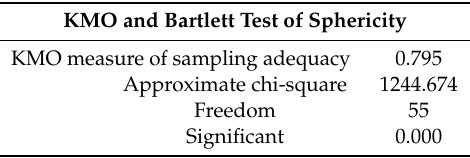
Table 3. KMO (Kaiser-Meyer-Oklin) and Bartlett Test of Sphericity for the data of safety consciousness.